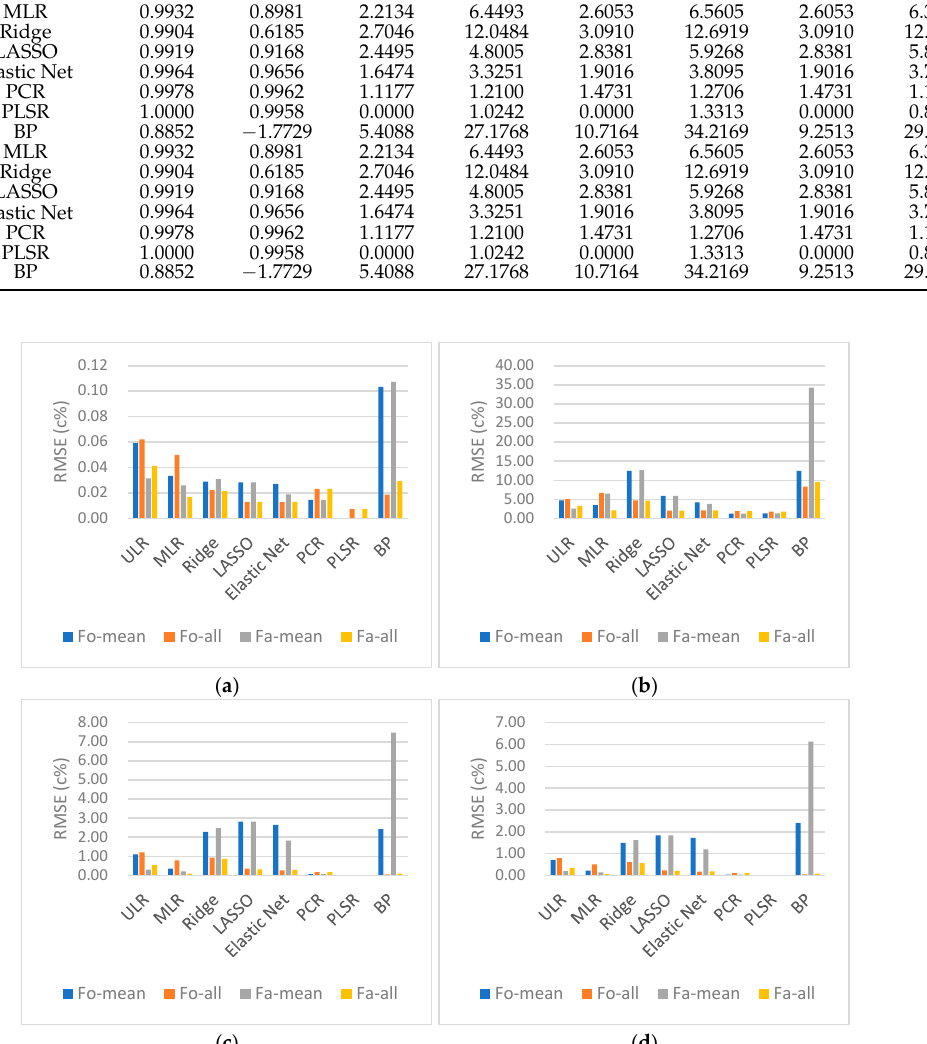
Figure 8. Accuracy of the calibration and validation on the training set and testing set with RMSE: ( a , b ) accuracy of calibration on training and testing; ( c , d ) accuracy of validation on training and testing.